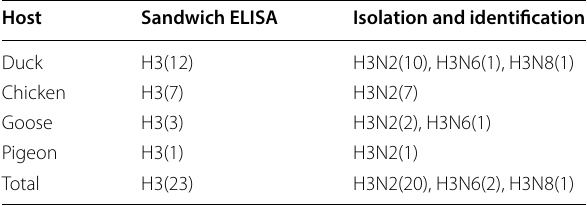
Table 2 Results obtained from clinical samples using this sandwich ELISA and isolation and